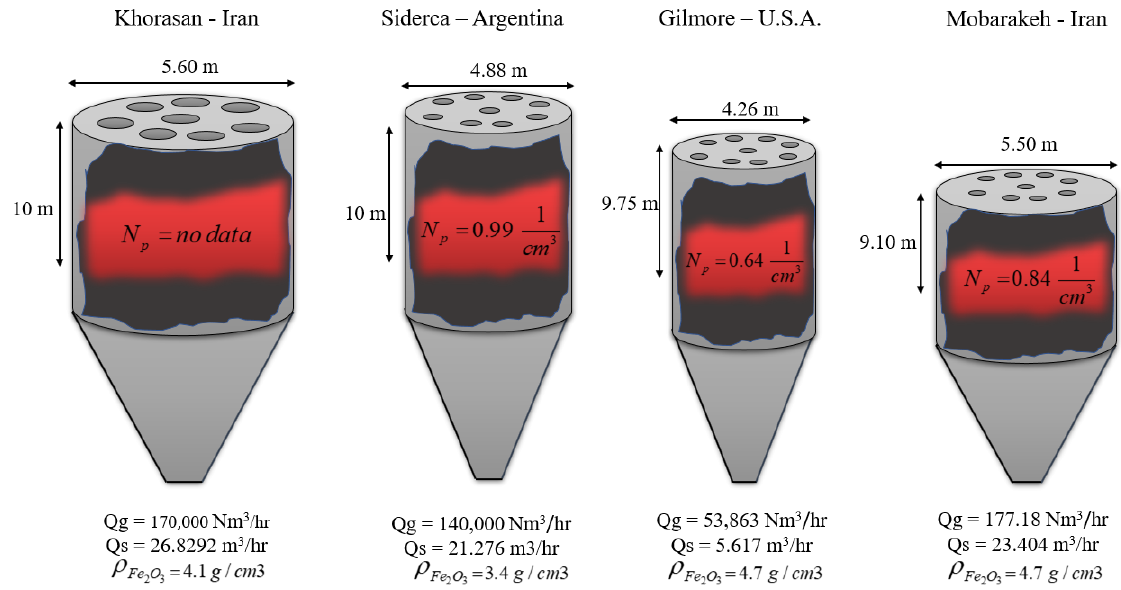
Figure 5. Different parameters in shaft furnaces at different plants.